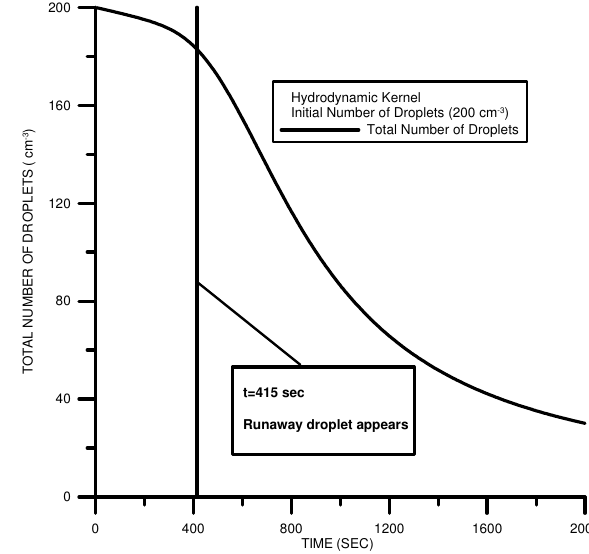
Fig. 9. Evolution of the total concentration calculated from the numerical solution of the KCE for the hydrodynamic kernel with bidisperse initial conditions. The initial total number of droplets is 200 per cm 3 .